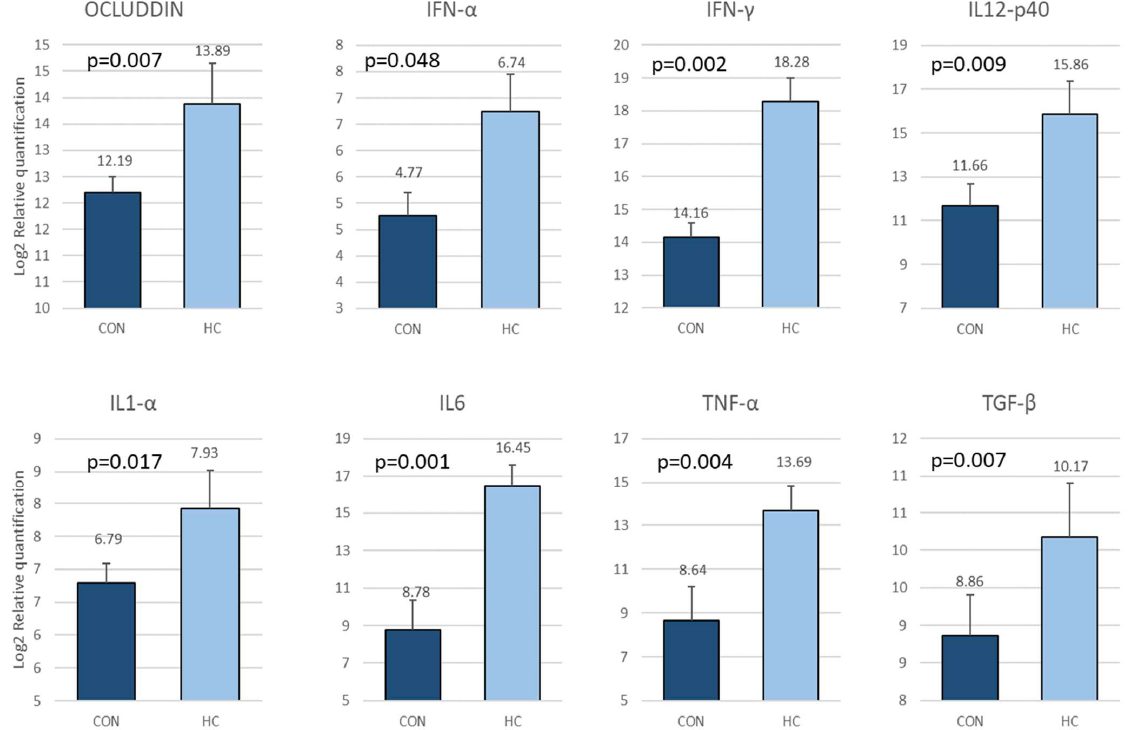
Figure 4. Biomarkers showing differences between CON and HC, expressed as Log2 of relative quantitation on fecal samples at first sampling. The results are expressed as Log2 of fold change, normalizing against the lower value which was assigned as 1. The bars represent Mean ± SEM.